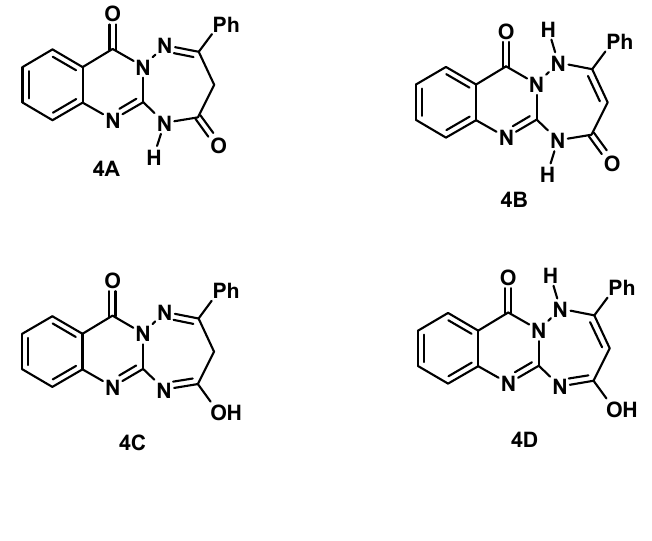
Figure 1. Four tautomeric structures A–D of 4